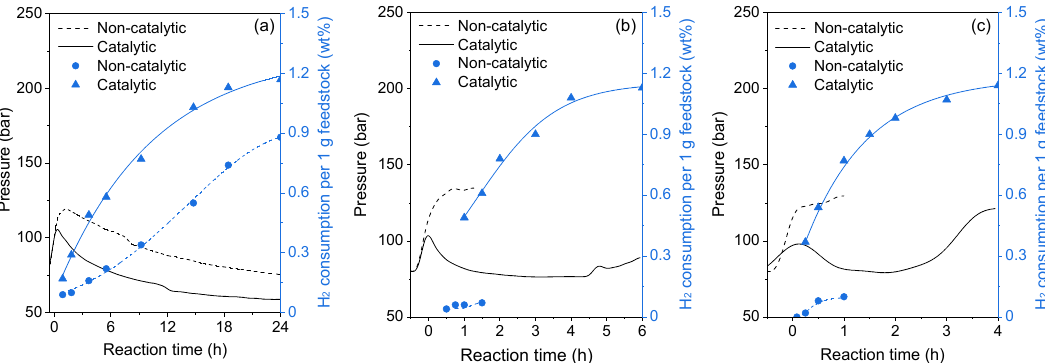
Figure 3. The profiles of reaction pressure and H 2 consumption per 1 g feedstock obtained from non-catalytic and catalytic hydrocracking of C 5 -Asp in batch reactor at ( a ) 380, ( b ) 410, and ( c ) 430 ◦ C. Reaction conditions: batch reactor, P H2 = 80 bar at 80 ◦ C, and 1000 wppm of Mo from Mo-octoate in catalytic hydrocracking.